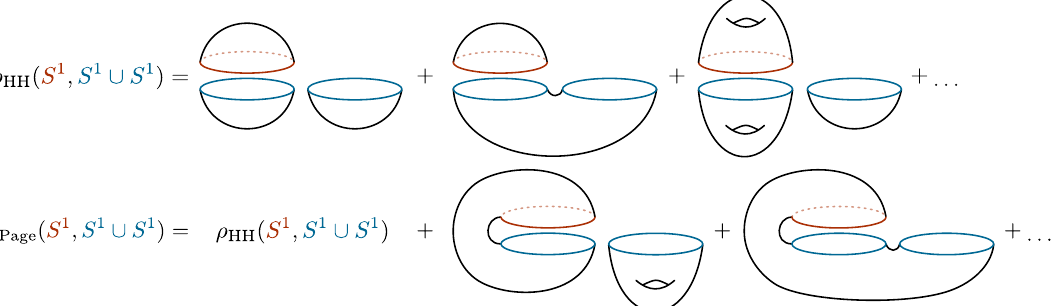
Figure 1: The difference between the Page density matrix ρ and the density ma- Page trix ρ corresponding to | HH y . This figure depicts contributions to a particular HH matrix element of these density matrices in two-dimensional gravity where a general Y is a union of disconnected circles. In red we indicated the bra and in blue the ket. In the Page density matrix (7) [ 27 ] , bra-ket wormholes are present, whereas they are absent in the density matrix for the Hartle-Hawking state (10) [ 25 ] . In par- p Y q is a superset of the ticular, the set of configurations that contribute to ρ , Y Page 1 2 p Y q configurations that contribute to ρ , Y HH 1 2